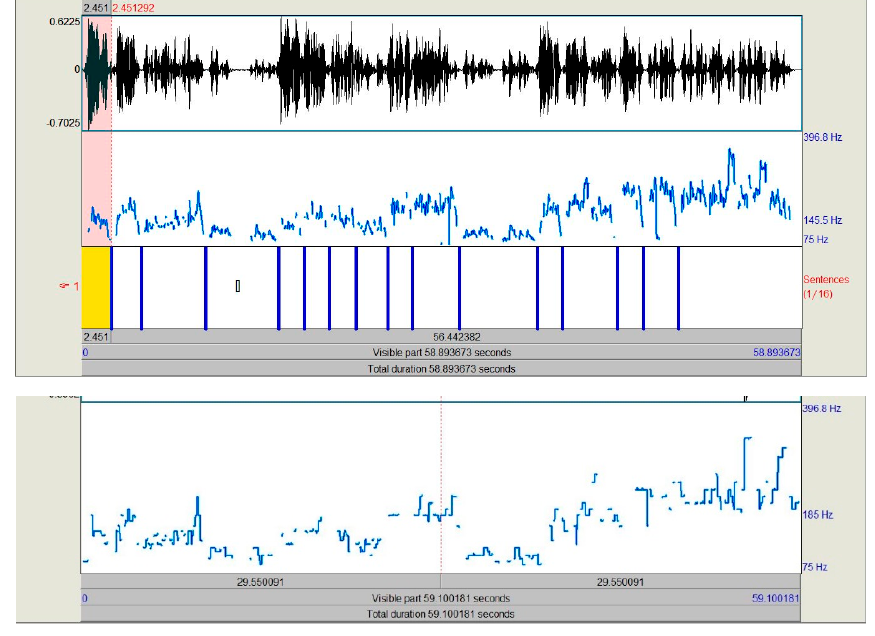
Figure A5. Stimulus 4—Pitch structure.